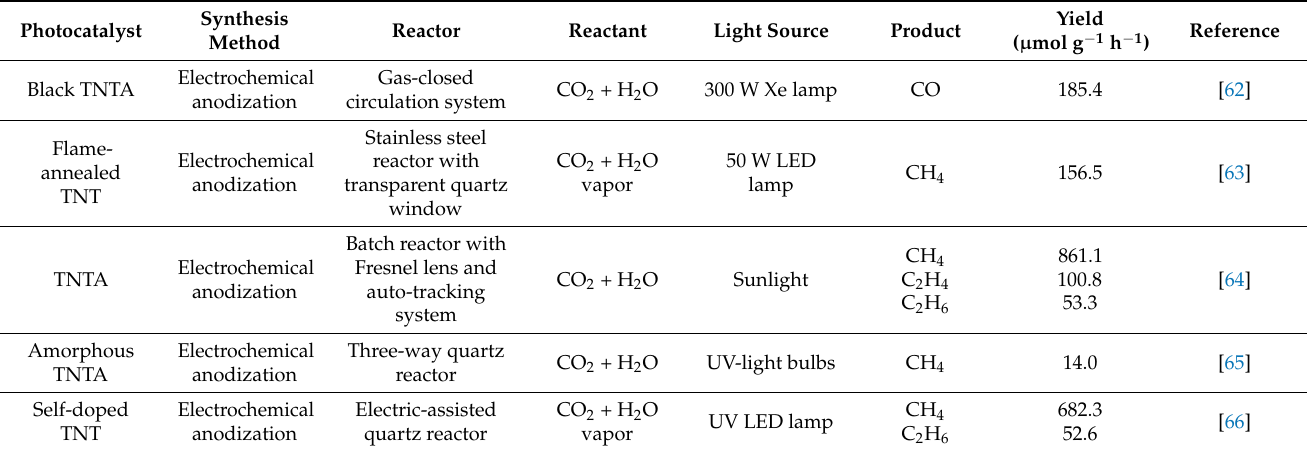
Table 2. Photocatalytic performance of TNTs for CO 2